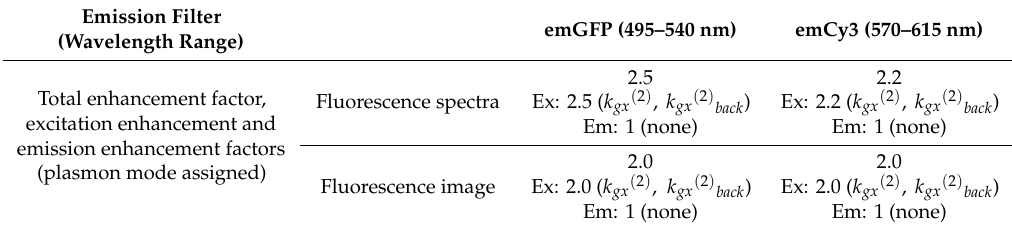
Table 5. Enhancement e ff ect of YG with exCFP for the 1D chip in the transmitted-light system.